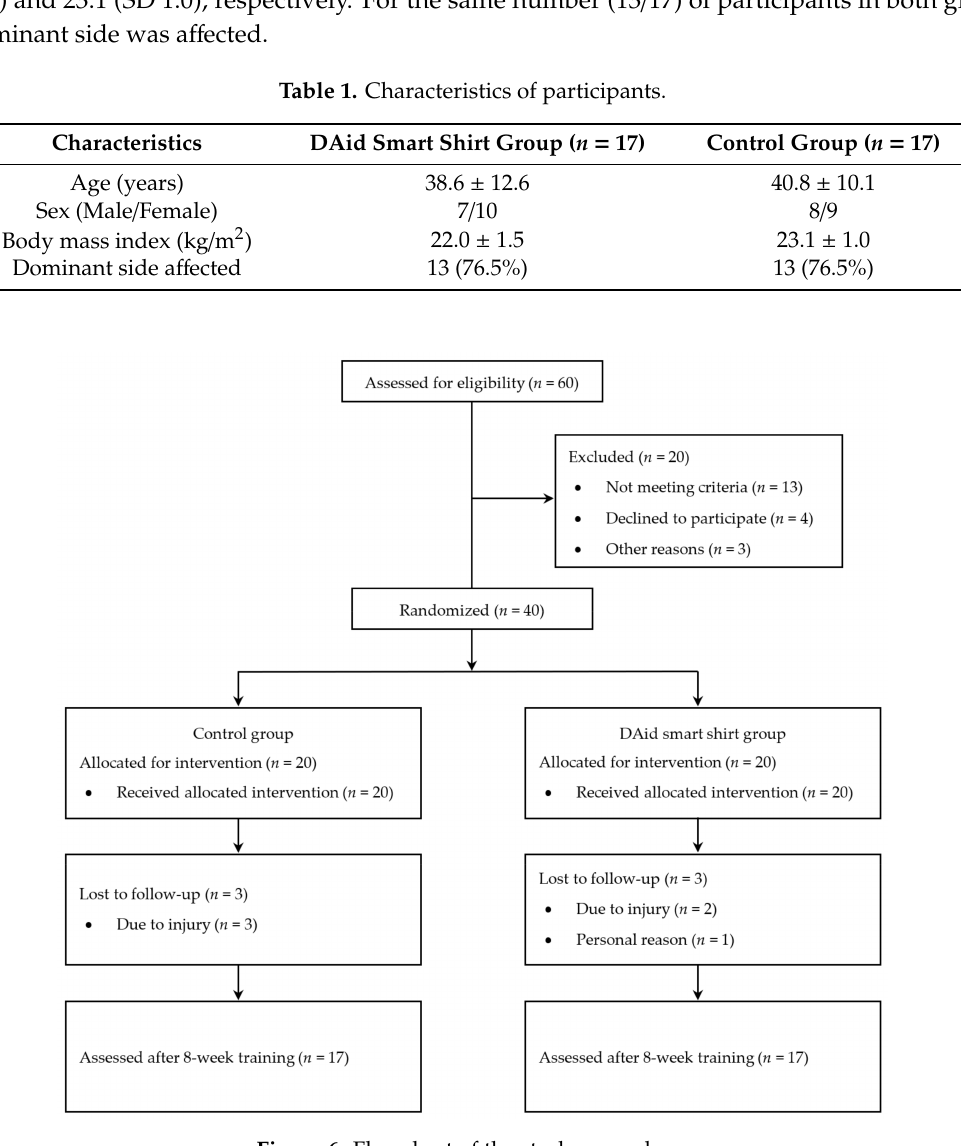
Figure 6. Flowchart of the study